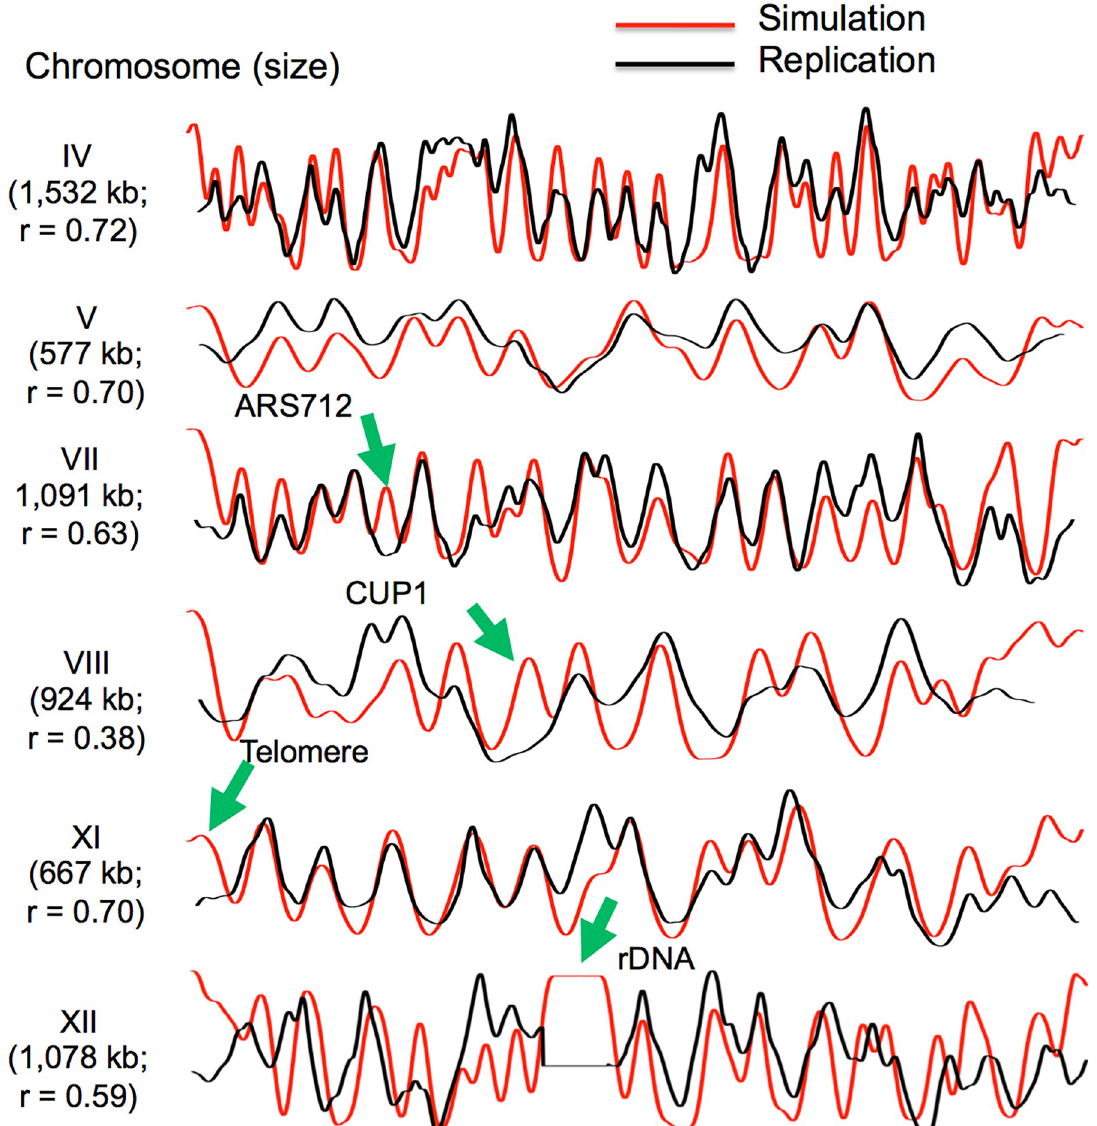
Fig 8. Comparison of replication simulations (red) and replication, as assessed by read depth ratios of S phase to G1 phase flow-sorted cells [50] for six S . cerevisiae chromosomes. Green arrows indicate sites that replicate later than would be predicted based on simulations including repetitive rDNA repeats, telomeres CUP1 locus and ARS712 . Delayed activation of these well-licenced origins indicates their control at the level of origin firing. ARS712 , which has been shown to contain both ORC and MCM in ChIP studies [52], is not active during unperturbed replication, but is active in rad53 mutants subjected to hydroxyurea [51]. Correlation coefficients (r) between simulations and replication data are indicated. Mcm2-ChEC read depth of all fragment sizes was used for calculating MCM